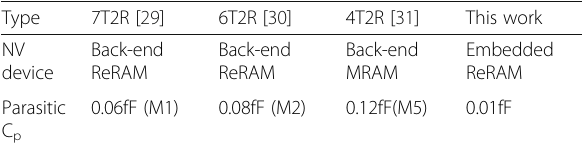
Table 2 Comparison between different nv-SRAM structures and this work